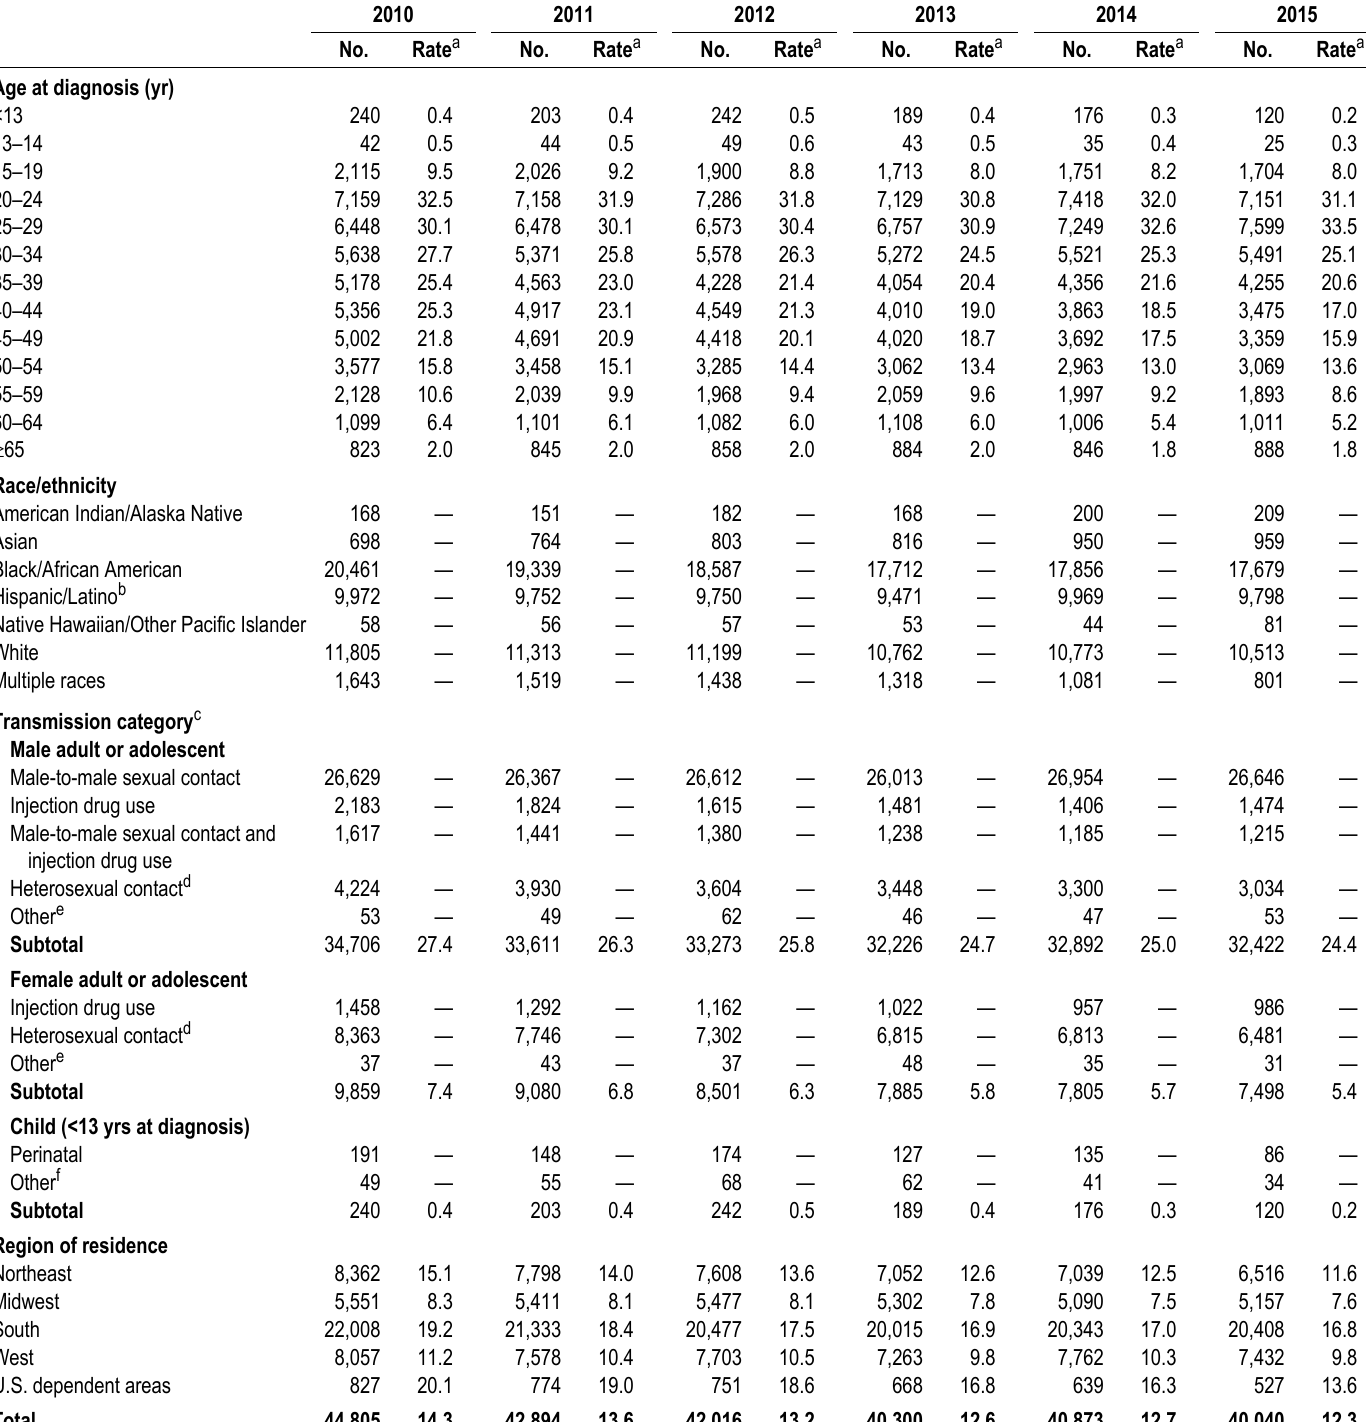
Table 1b. Diagnoses of HIV infection, by year of diagnosis and selected characteristics, 2010–2015—United States and 6 dependent